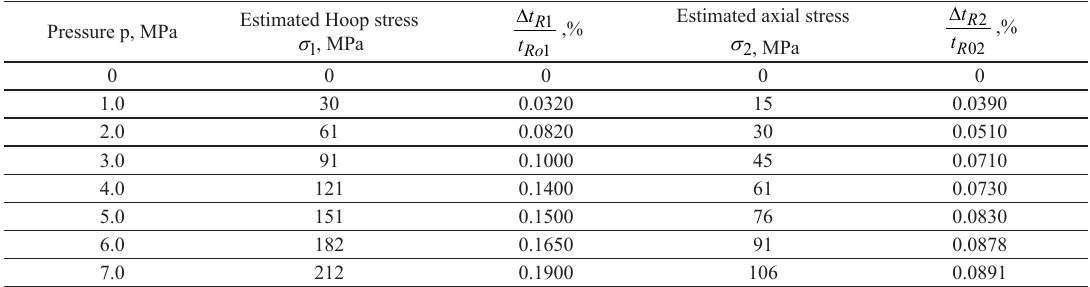
Table 1. Measurement results Pressure p,